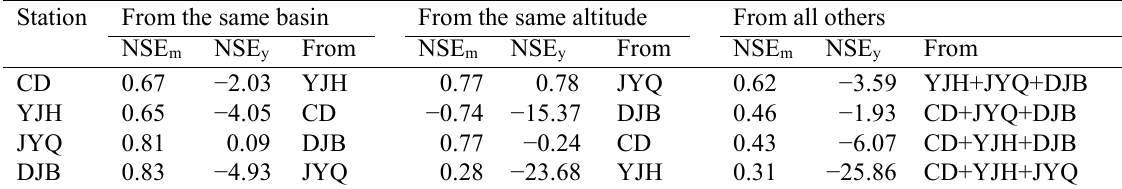
Table 6 The same as Table 5 but at monthly and yearly scale. Station From the same basin From the same altitude From all others